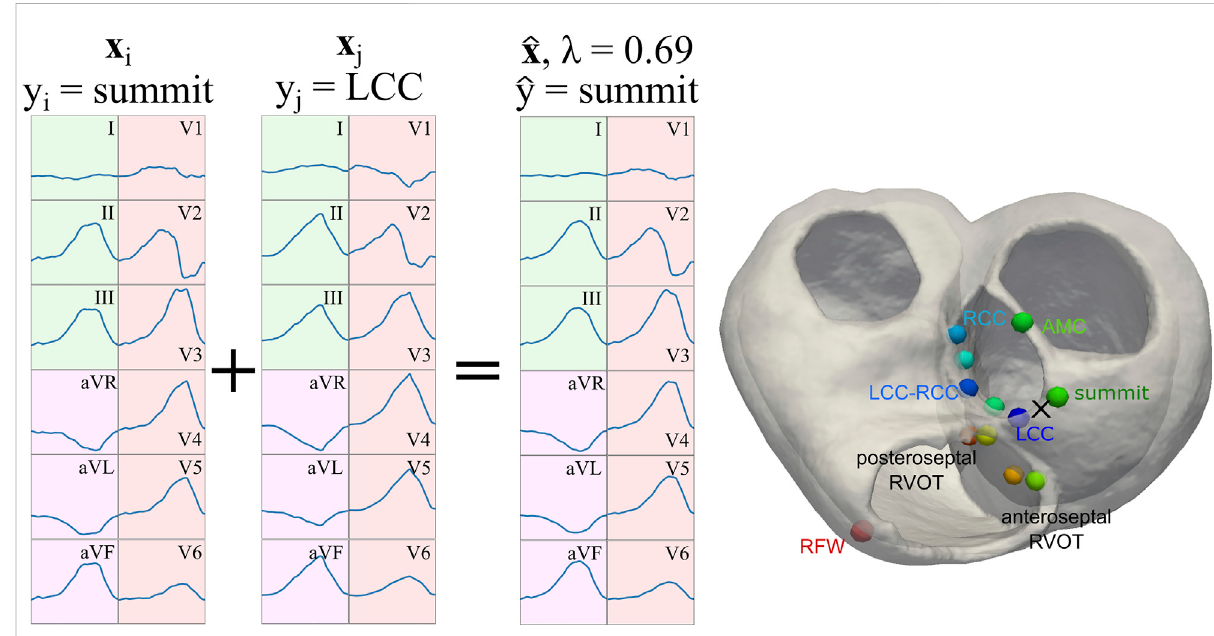
FIGURE 4 Representationofthesignalaugmentationprocess.Twosamples x i and x j arelinearlycombinedwith λ ~ B ( α , β ) .Thelabelof x i isadopted,given that λ > 0.5.Intheright,markedwithacross,theapproximatedlocationoftheaugmentedsample.LCC:leftcoronarycusp;RCC:rightcoronarycusp; RFW: right free wall; AMC: aortomitral continuity; RVOT: right out fl ow